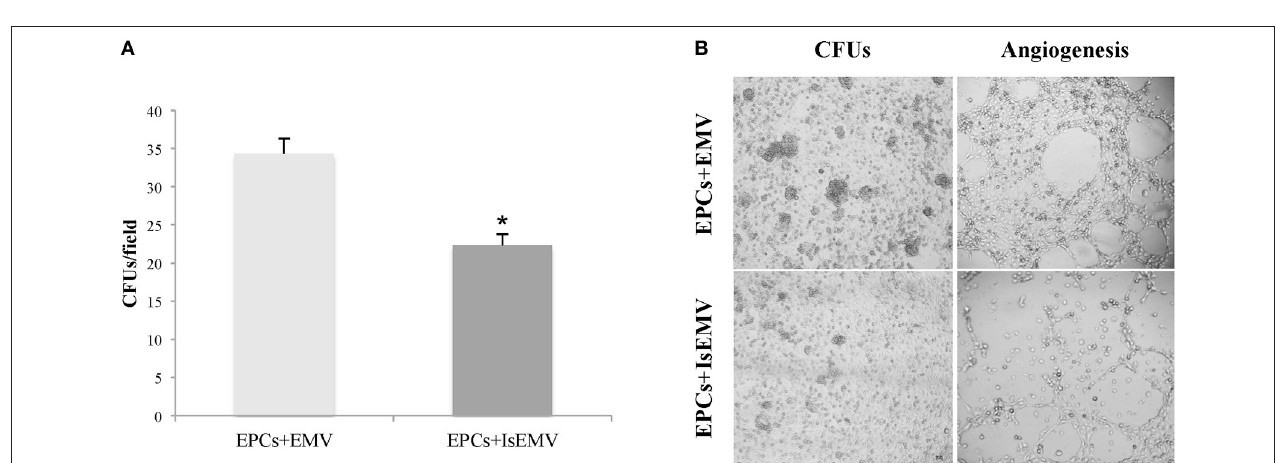
FIGURE 6 | Effect of microvesicles (MV) on endothelial progenitor cells (EPCs) colony formation and angiogenesis. EPCs obtained from healthy donors were treated with MV derived from IS-treated HUVECs (IsEMV) or untreated HUVECs (EMV) for 14 days. (A) Histogram of colony forming units (CFUs) per field under different experimental conditions. IsEMV significantly decreased the number of CFUs. Results are the mean ± SEM of three independent experiments. * p < 0.001 vs. EPCs treated with EMV. (B) Optical inverted microscopy images of CFUs in EPCs treated with EMV or IsEMV and representative images of tube-like three-dimensional structures of EPCs on the semi-natural matrix, Matrigel, 4 h after